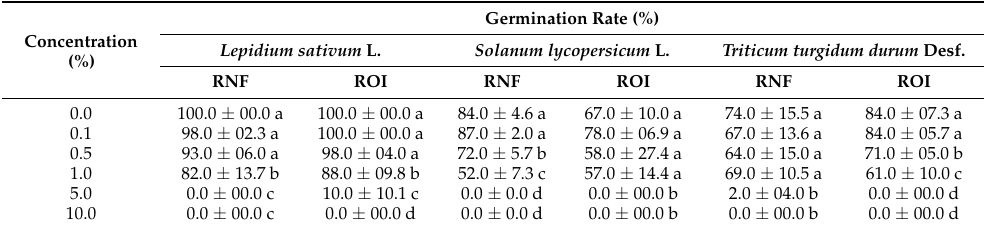
Table 3. Effects of different concentrations of retentates on germination rate of cress, durum wheat, and tomato (1).